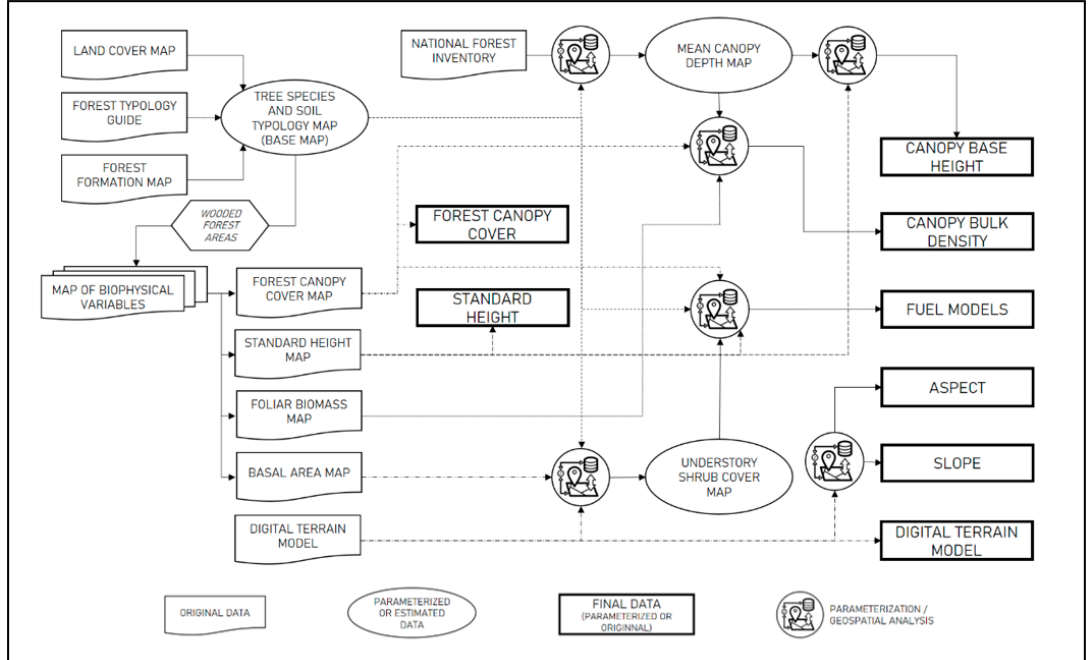
Figure 2. Schematic diagram of the landscape file (LCP) generation workflow.